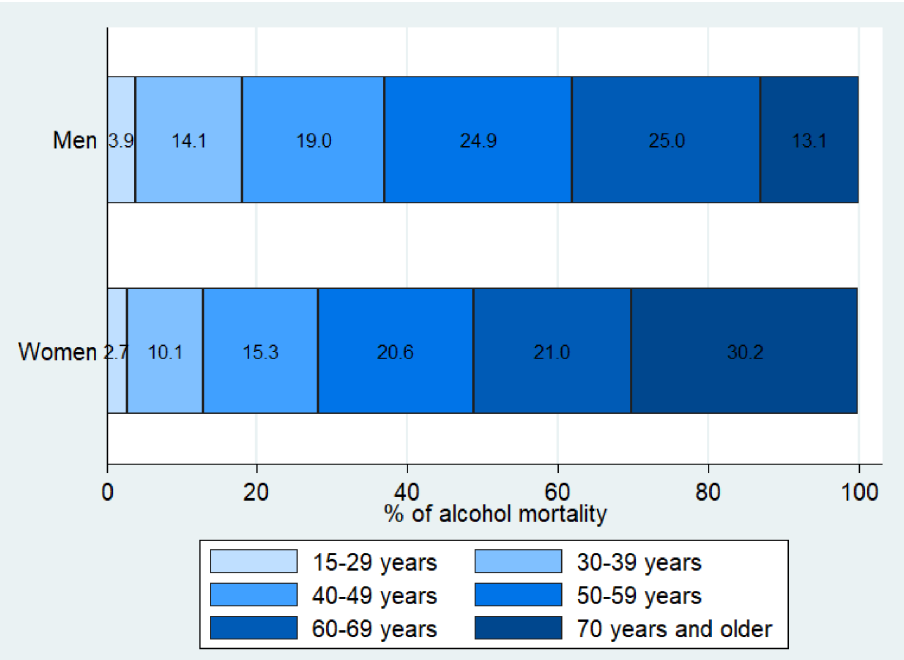
Figure 4. Number of deaths due to excessive alcohol consumption, depending on sex and age, pro- portion in alcohol mortality (%), men and women, 2018. Source : author’s calculations based on the RLMS and Russian Fertility and Mortality Database